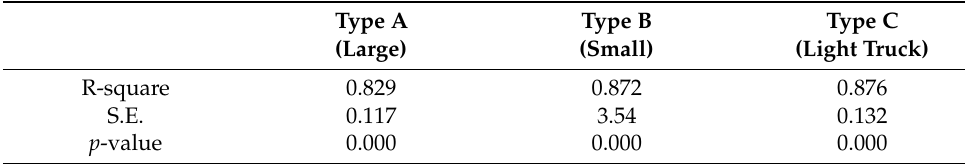
Table 3. The result of the linear regression models.